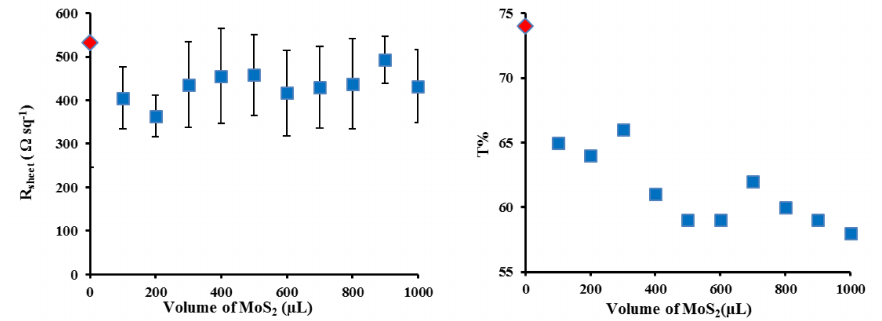
Figure 4. Sheet resistance ( left ) and optical transmittance @550 nm ( right ) of varying layered SWCNTs@ MoS 2 films thickness after all three chemical